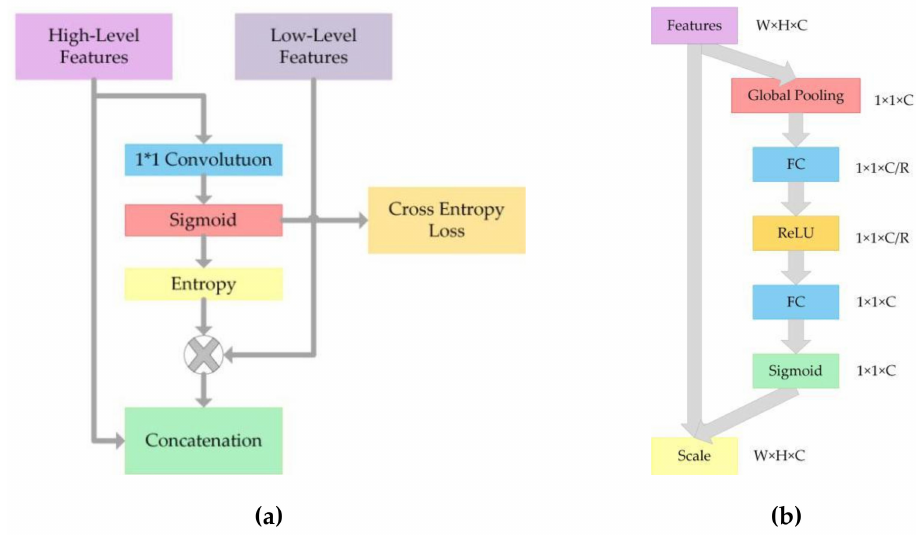
Figure 3. Composition modules in the GAN-SCA. ( a ) Spatial attention mechanism; ( b ) Channel attention mechanism. FC is fully connected